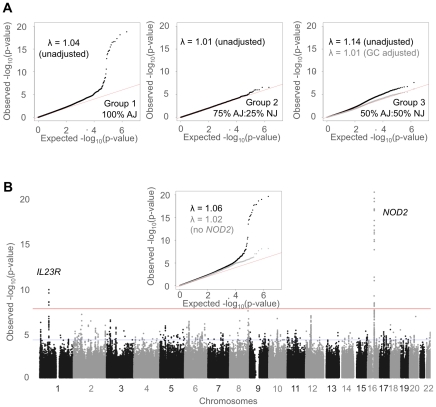
Association mapping of Crohn's disease in Ashkenazi Jews.(A) QQ-plots of the 100%, 75% and 50% AJ ancestry groups (Groups 1, 2 and 3, respectively). The inflation factors for the p-value distributions are given. For group 3, the p-values were genomic control-adjusted for over-inflation. (B) A Manhattan plot and QQ-plot (inset – in black) of the combined association scores from all three groups. The genome-wide threshold is shown in red and the replication threshold is shown in blue. The QQ-plot also shows association scores from all three groups but with 298 markers around the region of the NOD2 signal on chromosome 16 removed before association mapping (in grey).